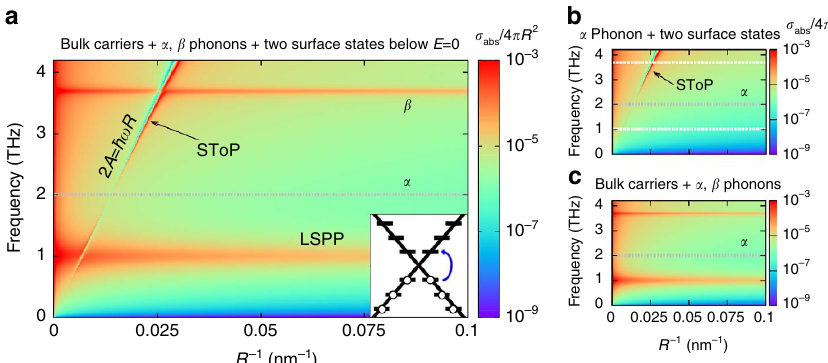
Figure 3 | Absorption modified by topological surface states. ( a ) When the topologically protected surface states are occupied up to the Dirac point, the two uppermost electrons (at energy (cid:2) A / R ) couple to empty states above the Dirac point (at A / R ). As a result, the absorption cross-section contains an additional maximum (SToP, marked with an arrow) and a zero, which depend on the radius of the nanoparticle. The screening effect (along the line 2 A ¼ : wR ) occurs when the energy spacing of surface states is matched by the incident radiation and the surface conductivity becomes infinite screening the bulk. The SToP mode arises, because the surface electron acts as a mediator of the interaction between light and the a -phonon (grey dotted line), which otherwise does not absorb. This mode interacts with the localised surface plasmon (LSPP) and bulk b -phonon (the two horizontal modes) giving rise to the splittings. ( b ) In this figure the free carriers and b -phonon contributions to the bulk dielectric function were artificially removed, tht is, w p b ¼ w p f ¼ 0 (the absent modes marked by white dashed lines). This shows that the SToP mode (marked with an arrow) originates from the interaction of the a -phonon with the surface states. ( c ) Cross-section of the nanoparticle without the effect of surface